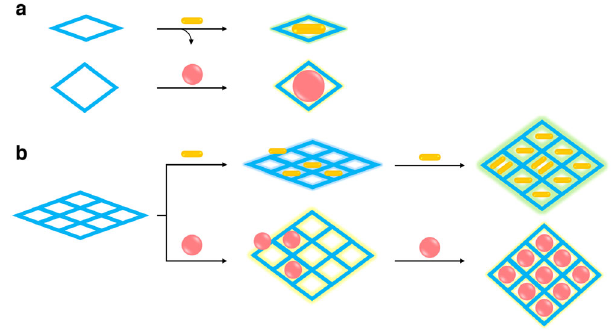
Fig. 1 | The working principle of guest-adaptive molecular sensing for dyna- COFs. a Traditional molecular recognition of the sizes and shapes of guest mole- culesviatheself-adaptivityofsupramolecularmacrocyclesandcagesformolecular sensinginliquids(solutions). b Dynamicandfunctionalcon fi nementspacesforthe docking of guest molecules and the adaptive inclusion of more guests to output molecular-speci fi c fl uorescent responses varied in intensity and colours for multi- plex molecular sensing of